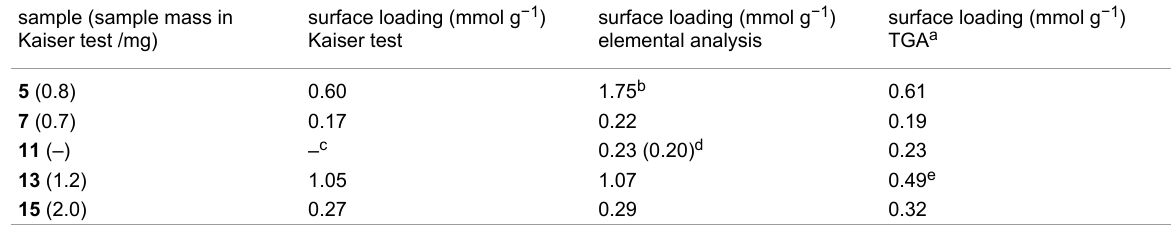
Table 1: Surface loading of nanodiamond-carrying amino groups on different linkers using three independent quantification methods. sample (sample mass in Kaiser test